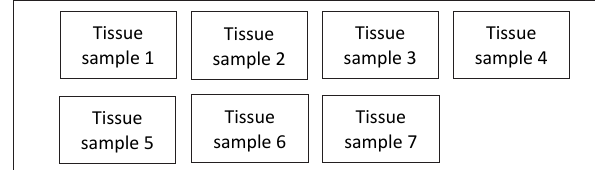
FIGURE 1: Wax block demonstration.